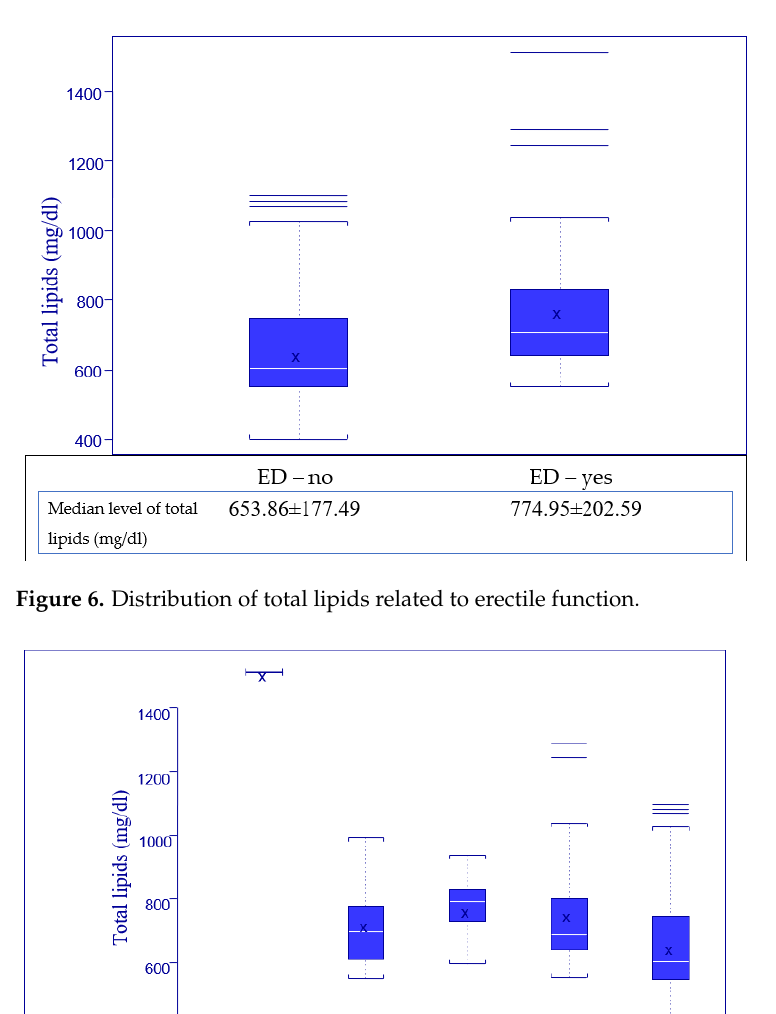
Table 5. Correlation between the level of total lipids and ED.